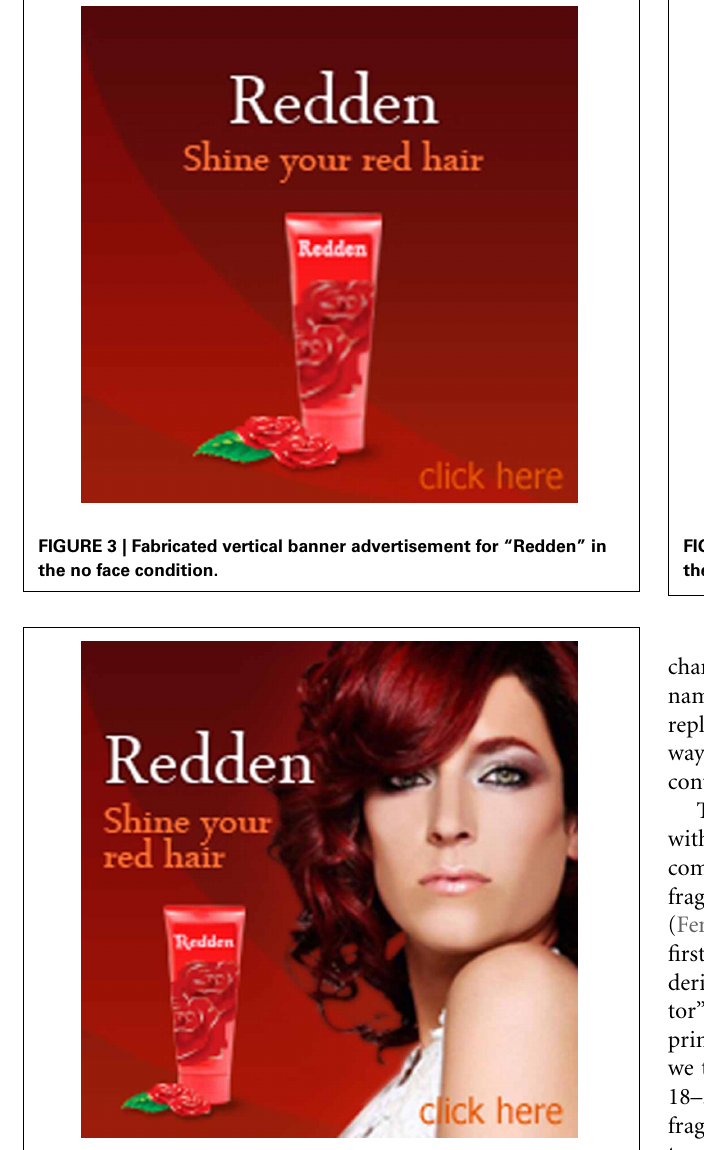
FIGURE 4 | Fabricated vertical banner advertisement for “Redden” in the mutual gaze condition.